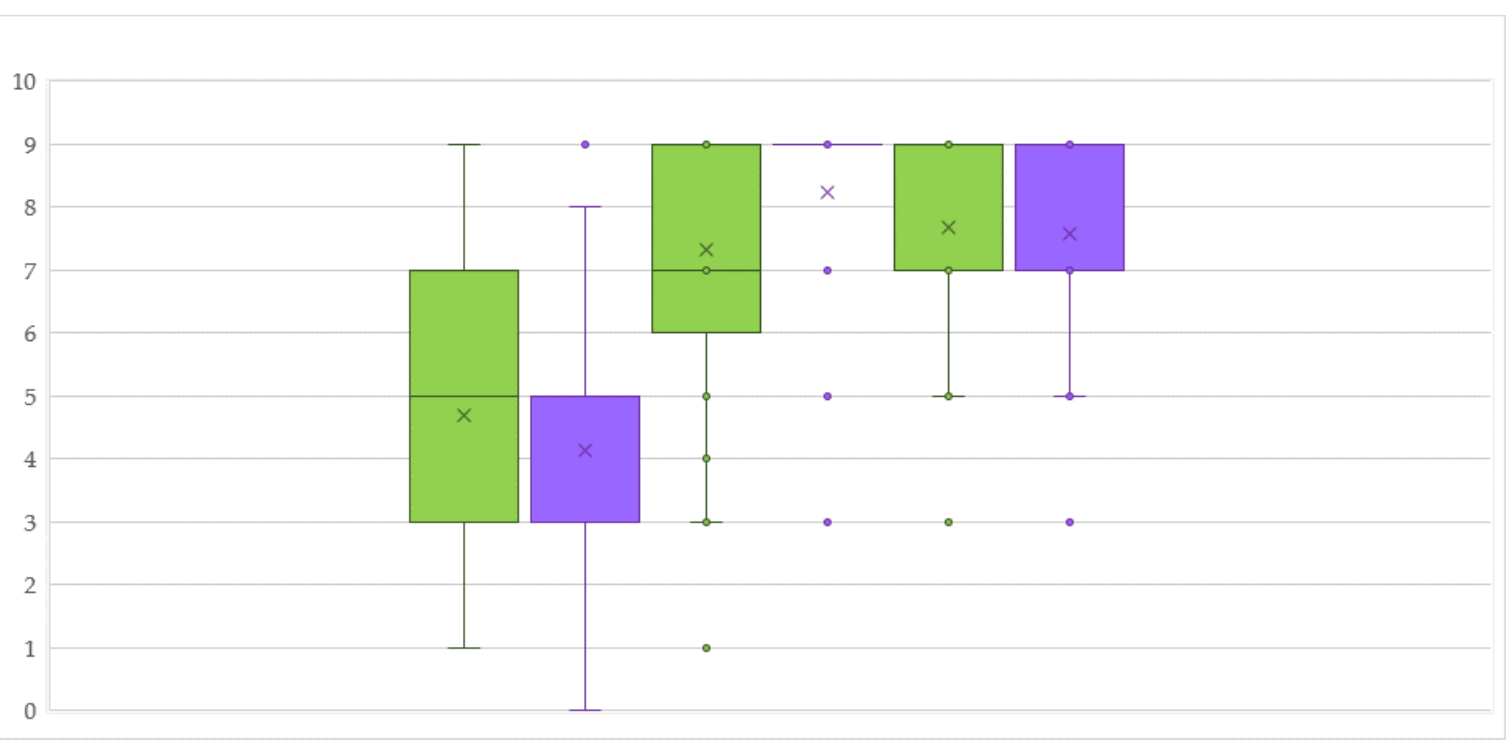
Figure 3. Box plots comparing OIV scores of resistance level in years 2016, 2017 and 2018 for downy ( A ) and powdery ( B ) mildew on leaves (green) and bunches (violet). Per each year, the lowest score between evaluations was chosen.